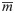
The scaling of μ
c corresponding to the onset of chaos with respect to L and m¯.